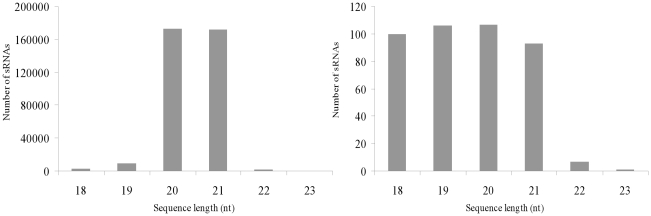
Size distribution of miRNA from tobacco roots.Left: redundant reads; Right: unique reads.